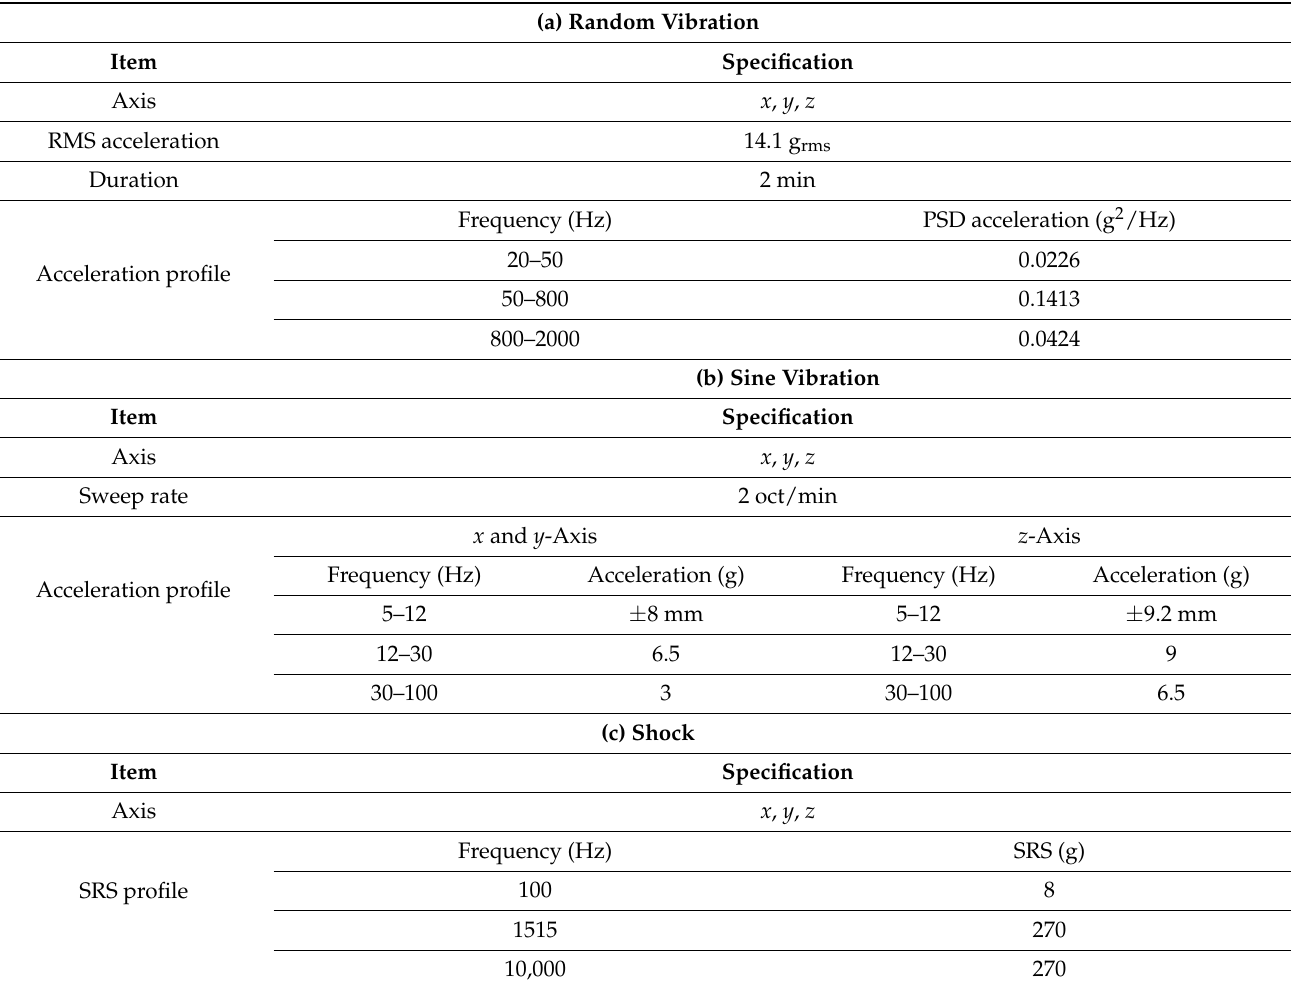
Table 2. Qualification level of launch environmental test